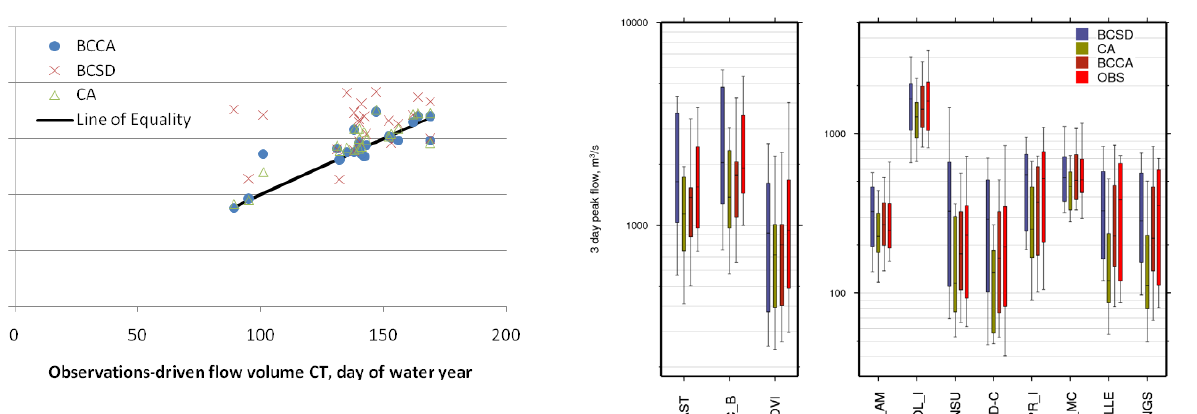
Fig. 6. Center timing for the NF AM site for 1977–1999 using each downscaling method, compared to the CT values for the observationally-derived streamflows. Units are day of the water year, as in Fig. 5.